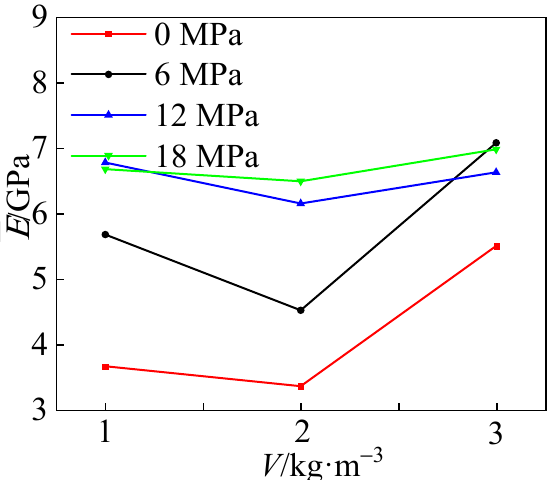
Figure 24. Effect of polypropylene fiber admixture on the average elastic modulus.